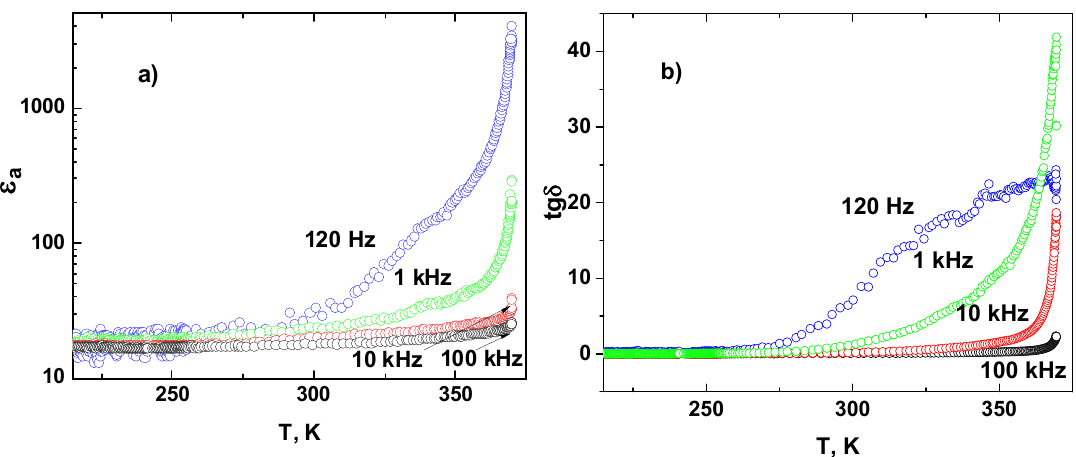
Figure 10. Temperature dependence of dielectric constant ε a (in semi-logarithmic scale) ( a ) and tg δ ( b ) in MBI-phosphite crystal along the a-axis for different frequencies f.